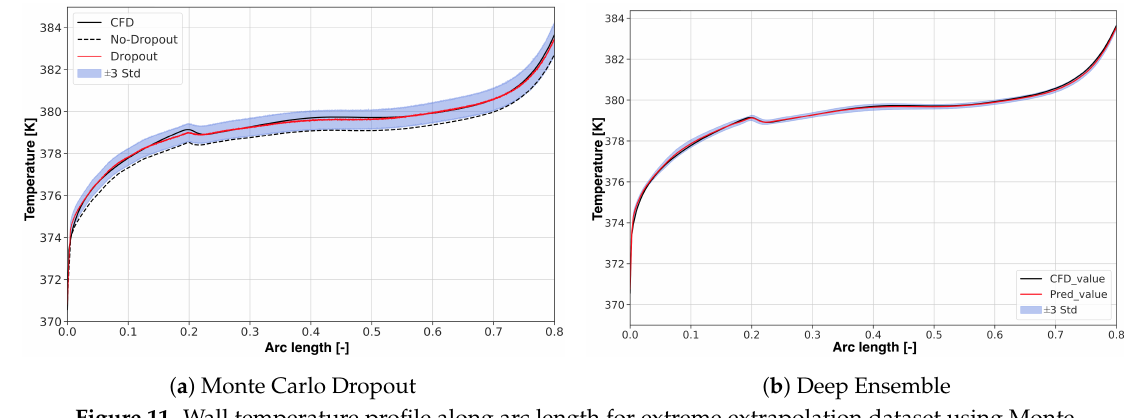
Figure 11. Wall temperature profile along arc length for extreme extrapolation dataset using Monte Carlo and Deep Ensemble models at q (cid:48)(cid:48) = 40,000 Wm − 2 and u = 0.2 ms − 1